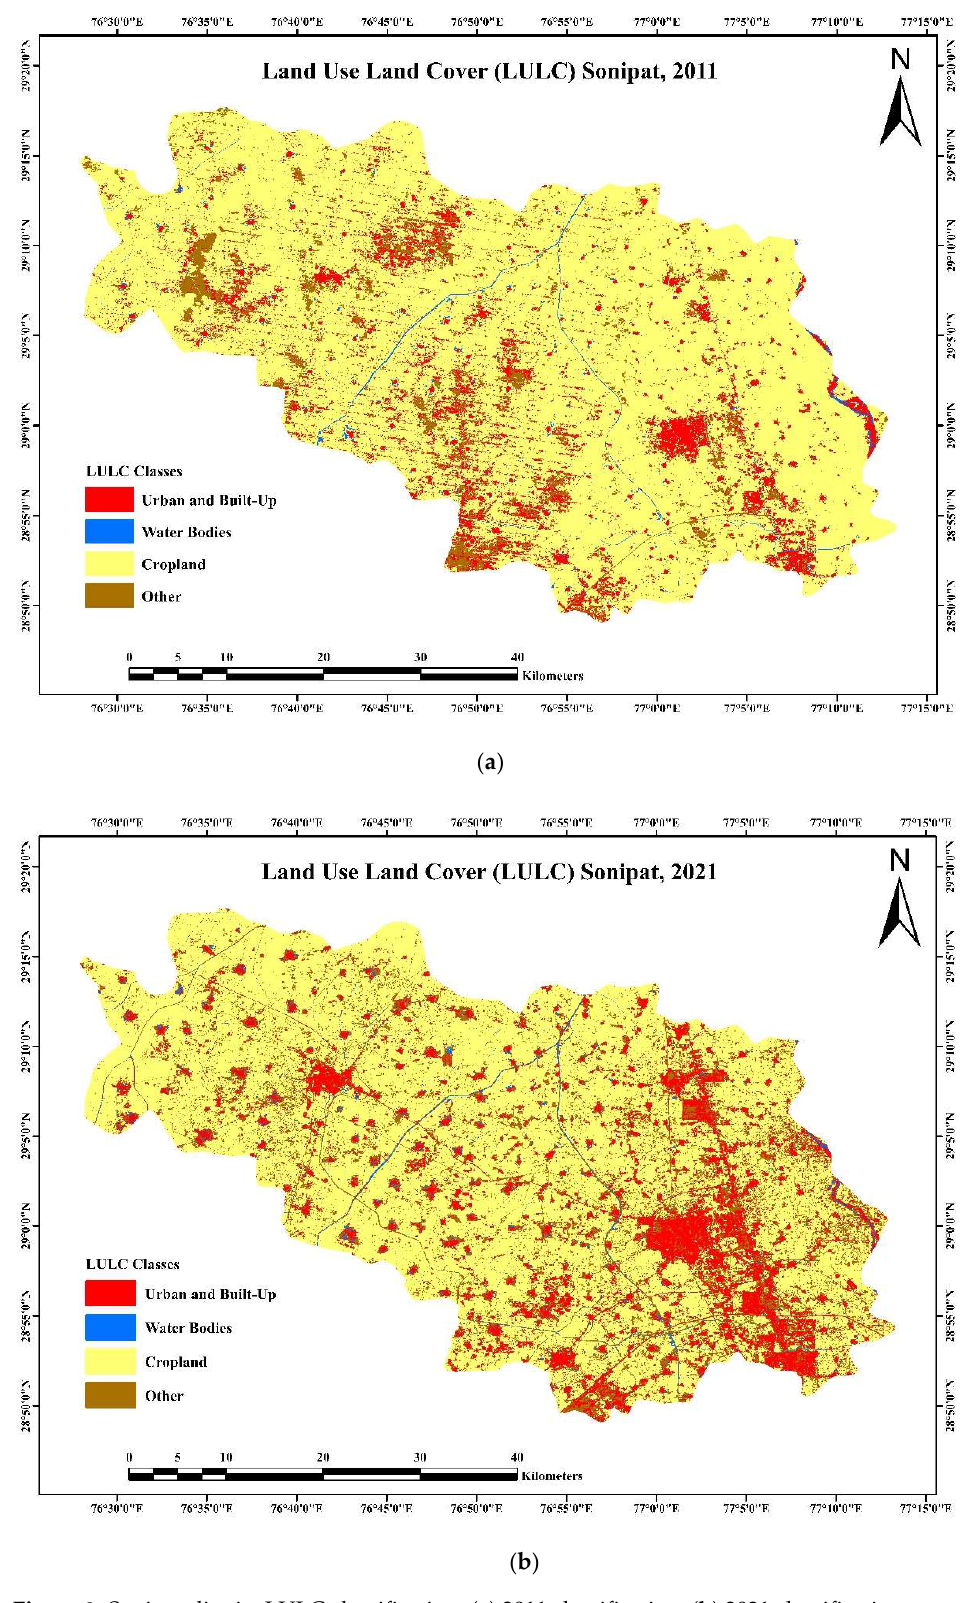
Figure 3. Sonipat district LULC classification: ( a ) 2011 classification; ( b ) 2021 classification.